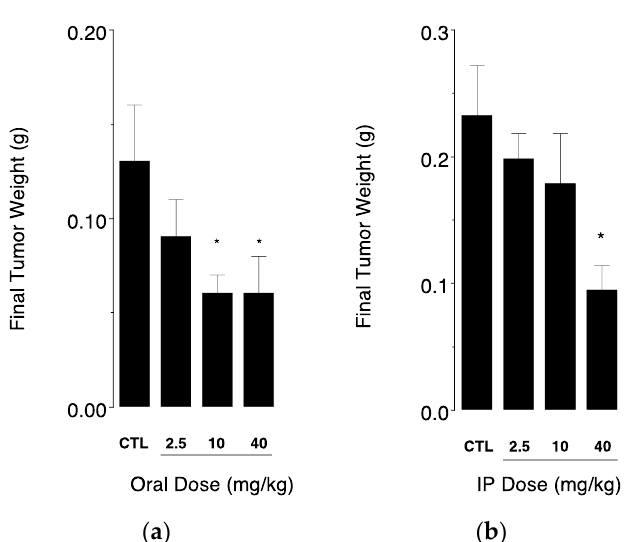
Figure 5. Final weights of excised tumors were determined at necropsy for ( a ) mice receiving increasing doses of ClFPh-CHA-loaded nanoemulsion orally and ( b ) mice receiving increasing doses of ClFPh-CHA in solution by intraperitoneal injection (32 days and 38 days of daily treatment for oral and IP administration, respectively). Values were compared to tumor weights of control groups of mice that received vehicle only (CTL). Different from control: * P < 0.05.